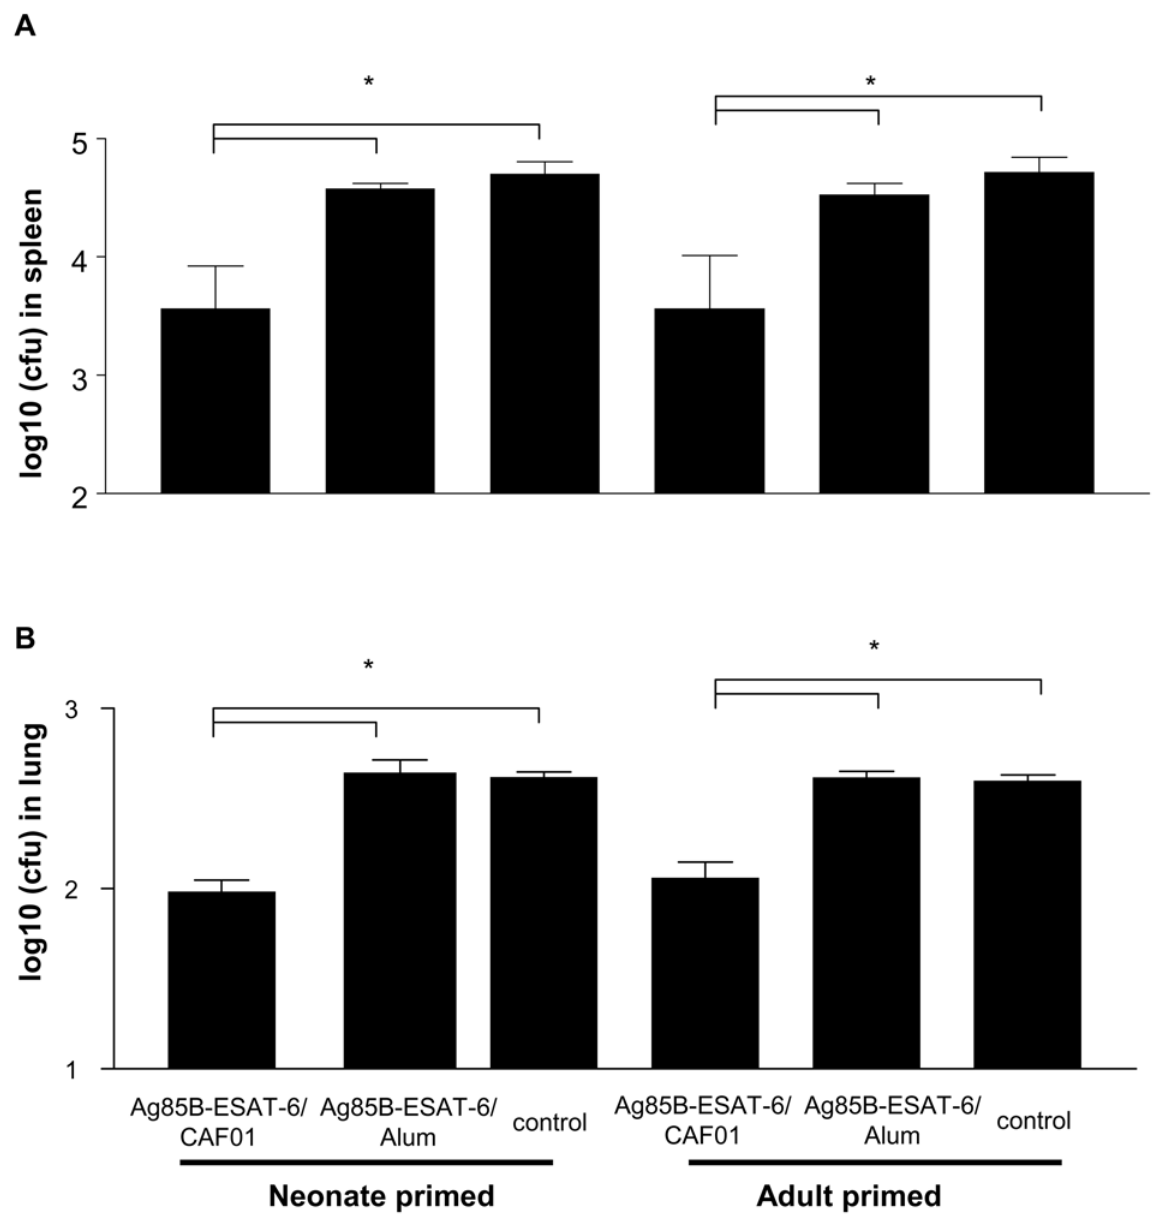
Figure 1. Ag85B-ESAT-6/CAF01 protects neonates and adults from mycobacterial infection. Immunized neonatal and adult mice were challenged with Mycobacterium bovis BCG i.v. The CFU in spleen (A) and lung (B) (mean and SD, 6–8/group) were determined four weeks later, and is representative of 2 independent experiments. *, p , 0.05, differences between CAF01 and Alum or control were significant.